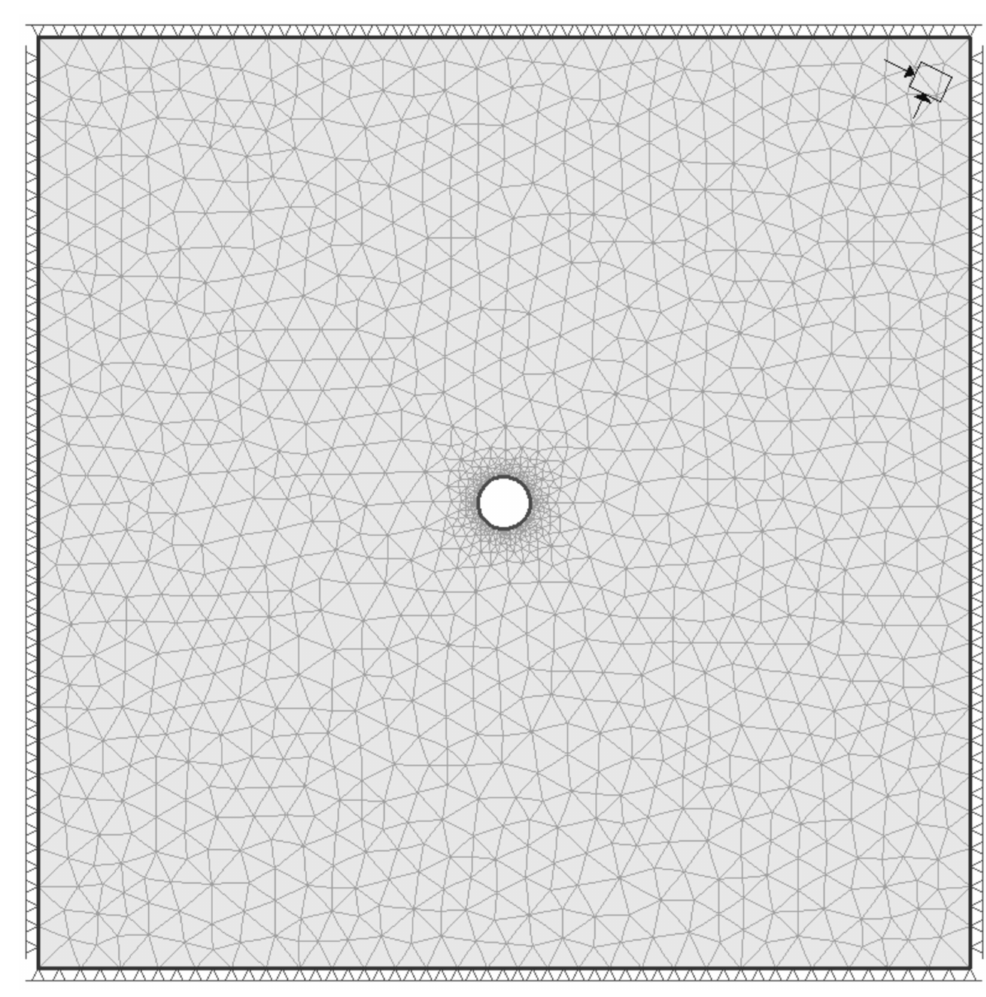
Figure 6. Shaft numerical calculation model.